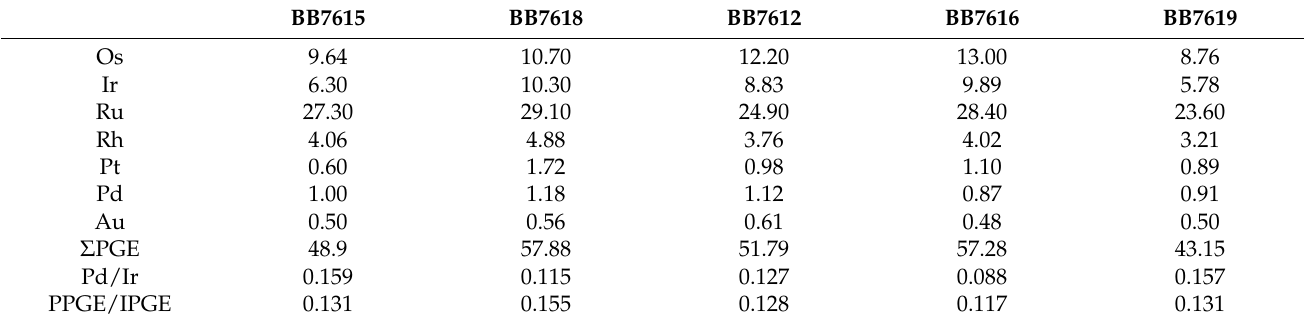
Table 6. Bulk rock PGE concentrations (ppb) in chromitite from the Bolshoi Bashart deposit (Southern Kraka).